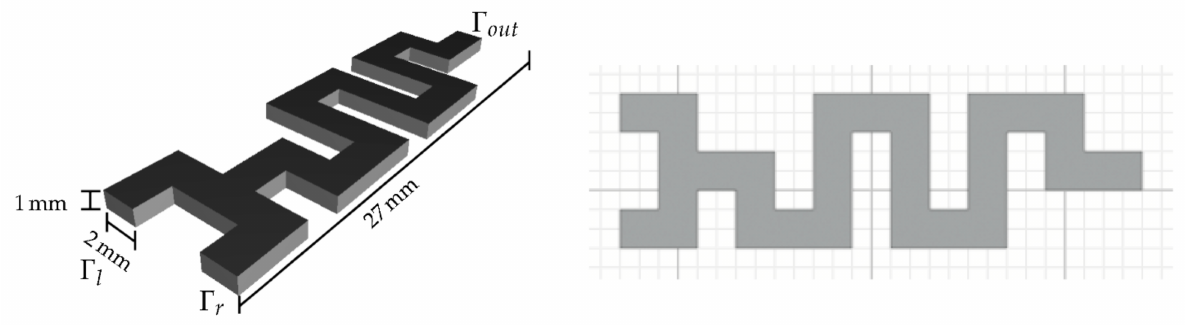
Figure 16. Geometry of the micromixer investigated by Jeßberger et al. ( Left ) Below in the picture are the two inlets Γ l, Γ r and the T-junction. On the top, we find the outlet Γ out. ( Right ) Dimensions of the channel in the xy-plane on a grid with width 1 mm. Reprinted from an open access source